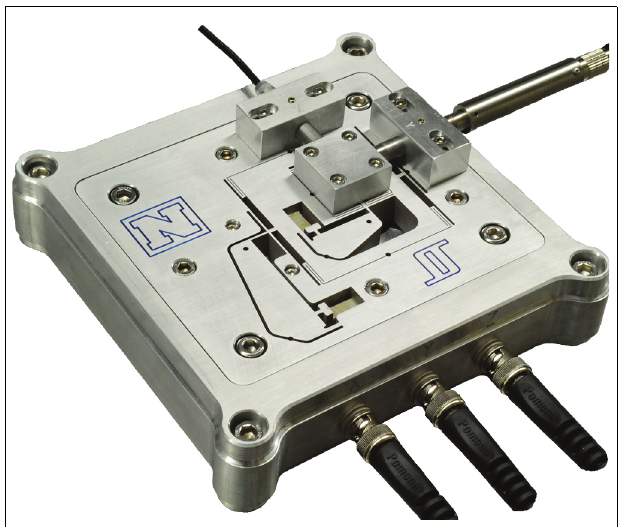
FIGURE 1 | A two-axis serial-kinematic nanopositioning platform with a range of 30 (cid:22) m .